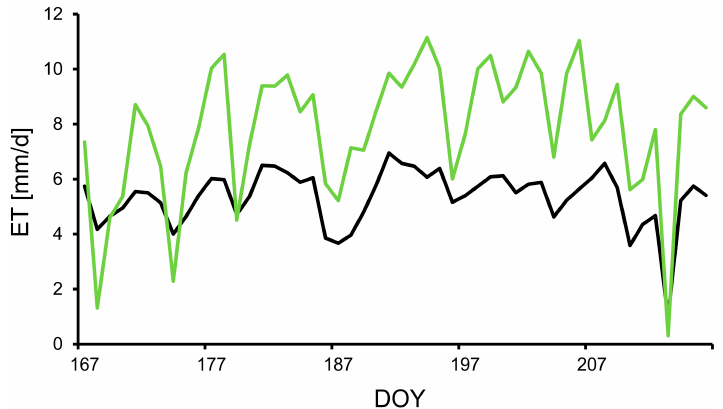
Figure 5. ETo (mm/d) and daily ET (mm/d) of shelterbelt from 15 June (DOY 167) to 3 August (DOY 216). DOY refers to n th day of the year.